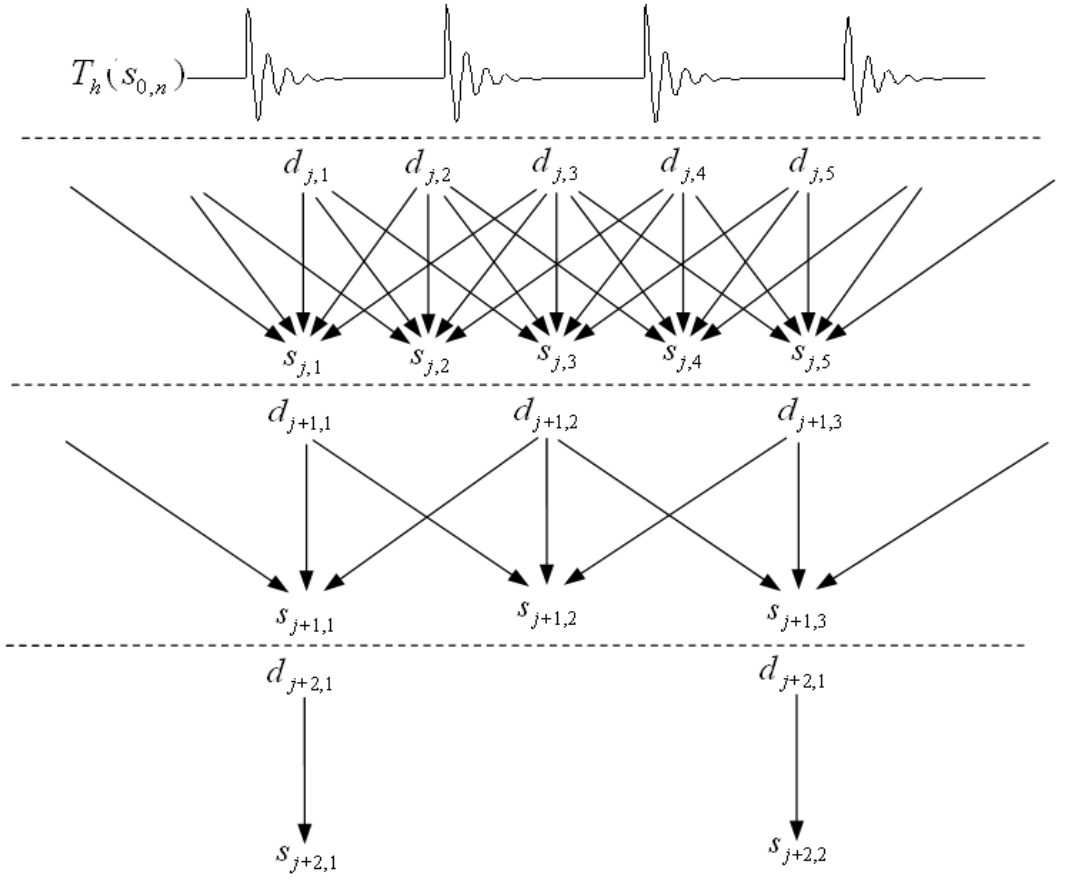
Figure 4. The algorithm of improved neighboring